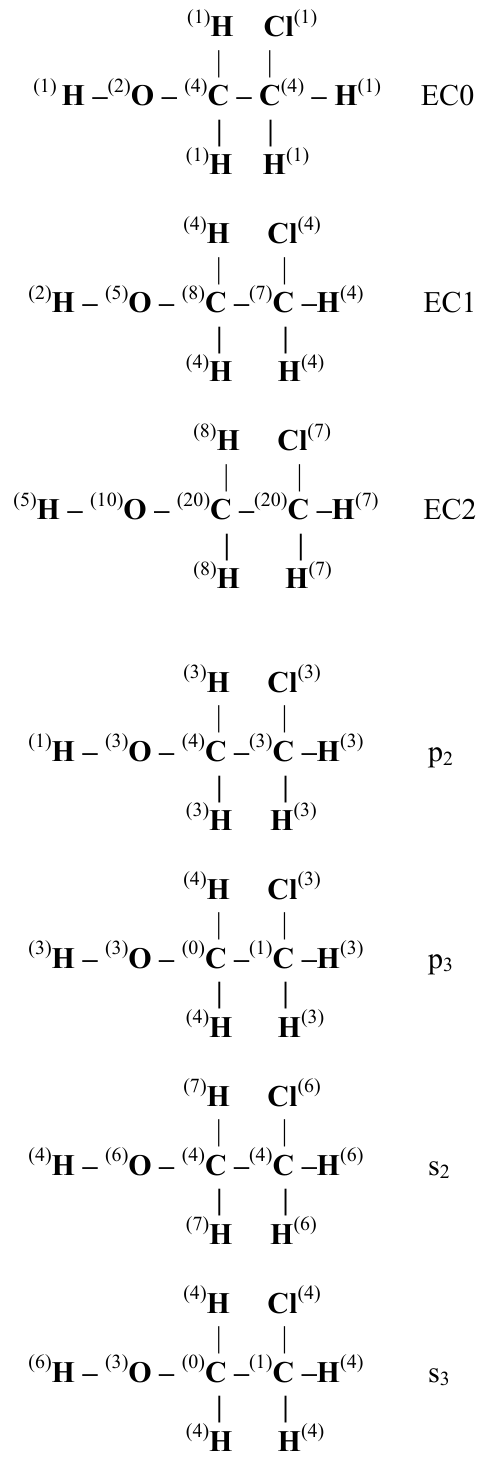
Figure 1. Numerical values of LHFG invariants of